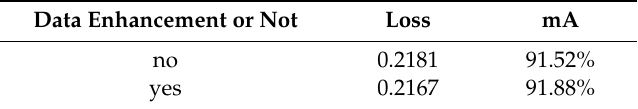
Table 2. The impact of data enhancement on recognition accuracy.